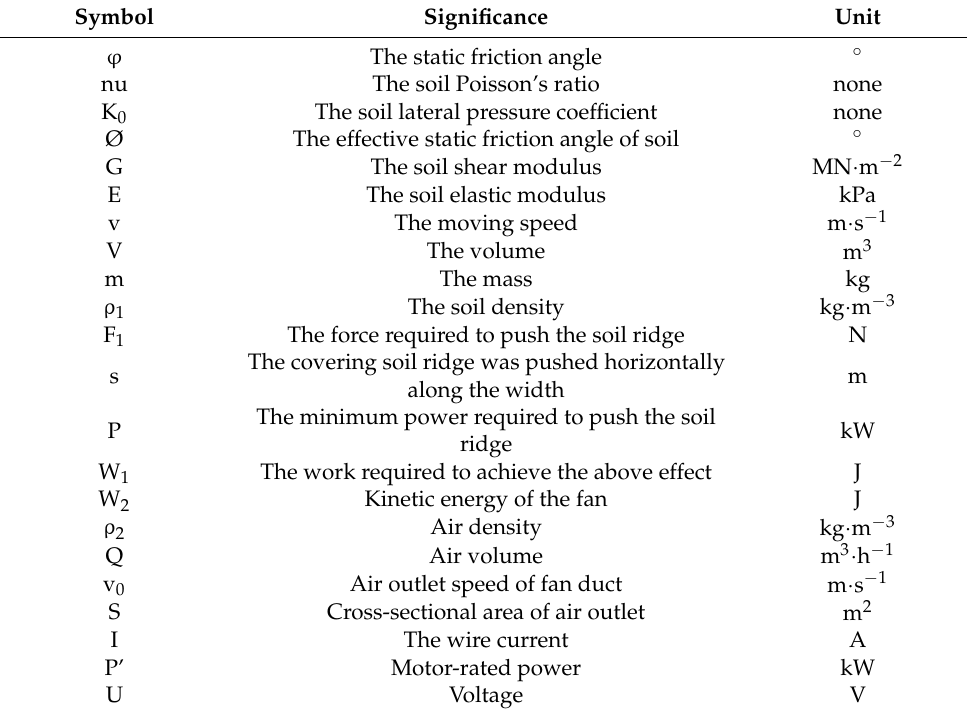
Table 7. Nomenclature.